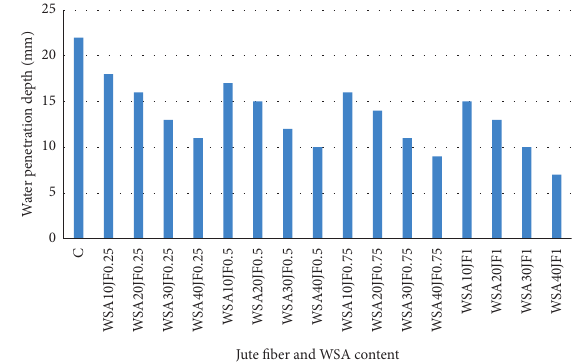
Figure 13: Permeability of mixture containing jute fiber and